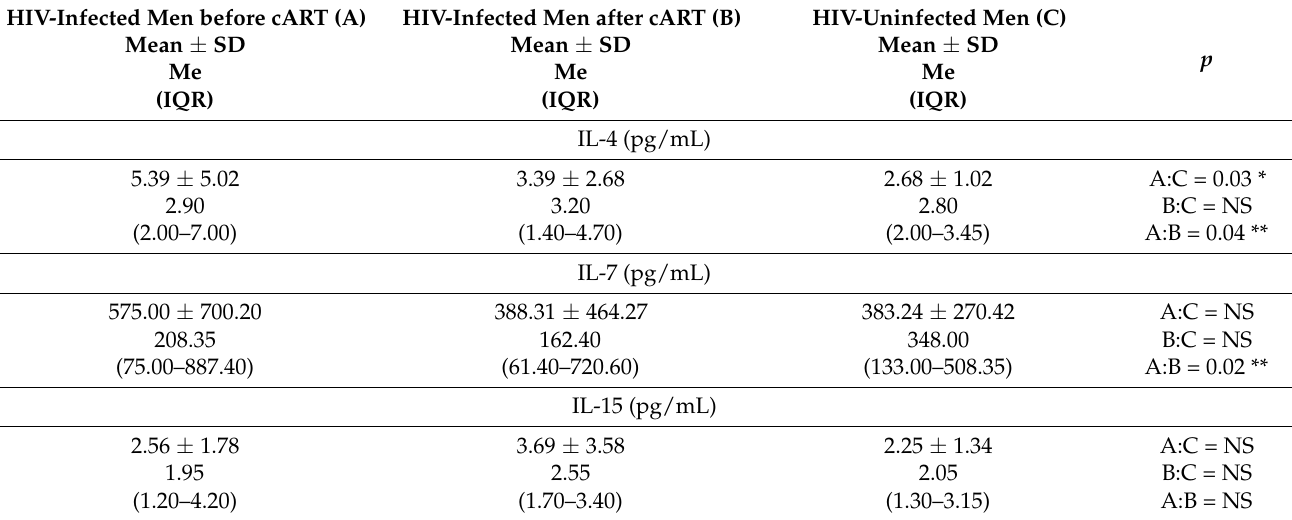
Table 2. Results for IL-4, -7, -15 in HIV-infected men before cART(A), after cART(B) and in the control group (C) with statistical